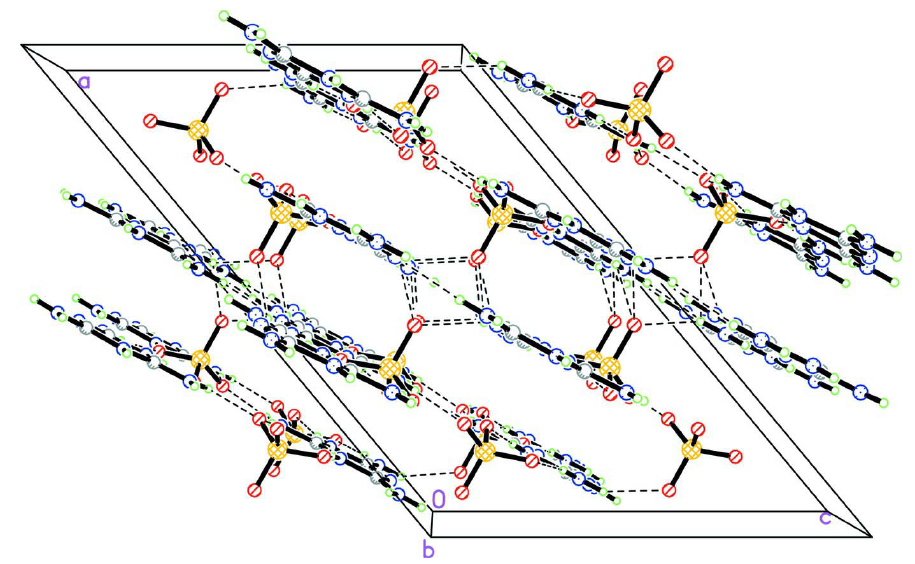
Figure 3 The molecular packing of (I) in the unit cell showing the hydrogen-bonding interaction (dashed lines). Melaminium